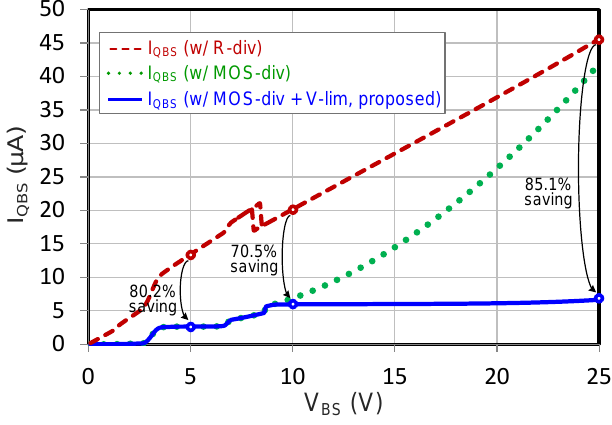
Figure 9. Quiescent current consumption of high-side UVLO circuits.